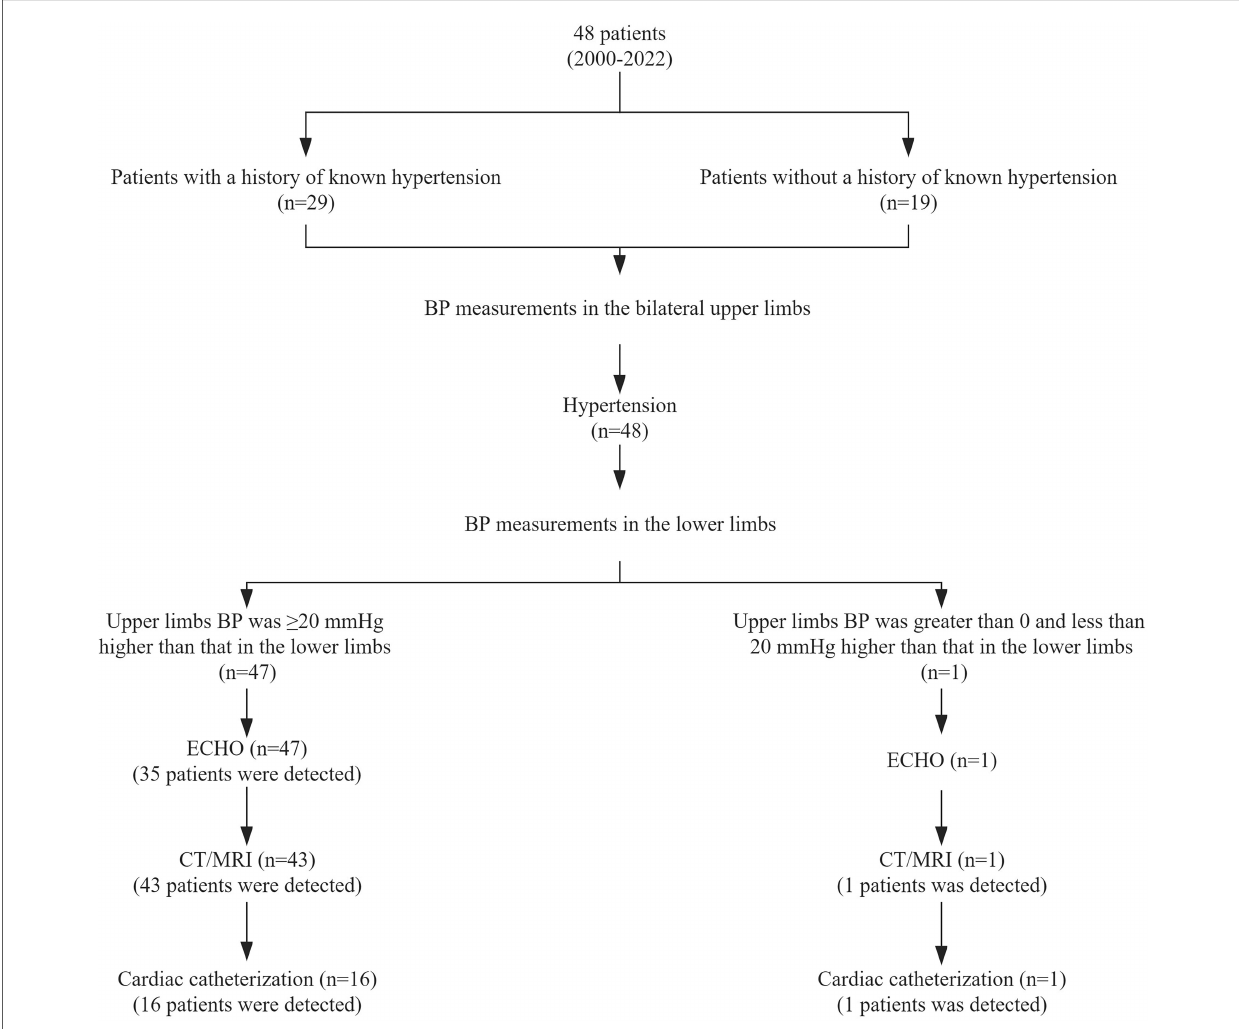
FIGURE 1 Preoperative diagnostic work fl ow at our institution, and detection rates of imaging examinations. CoA, coarctation of the aorta; BP, blood pressure; ECHO, echocardiogram; CT, computed tomography; MRI, magnetic resonance